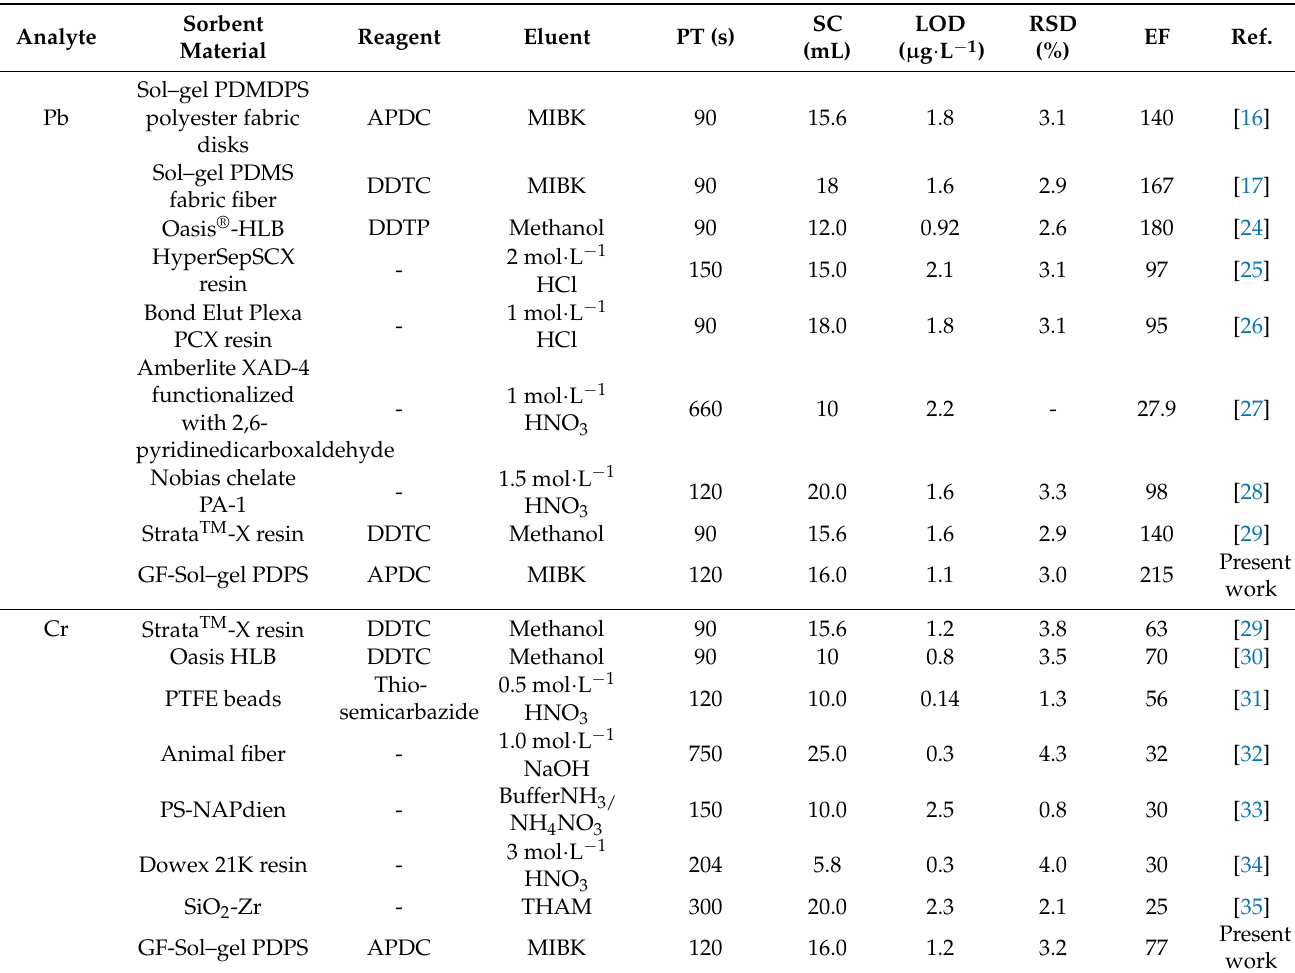
Table 3. Comparisons of the analytical performance of the present method with other on-line SPE-FAAS methods reported in the literature for lead and chromium(VI) determination. SPE: solid phase